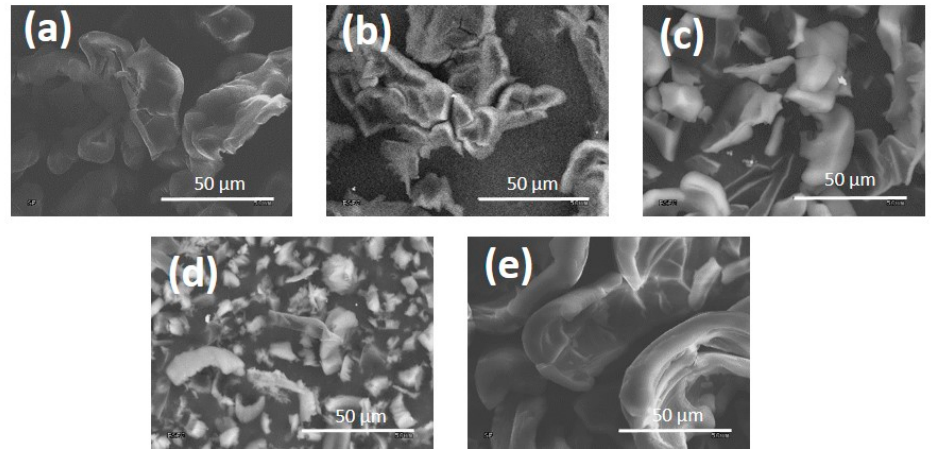
Figure 1. Powder produced using ( a ) methane; ( b ) methane and hydrogen mixture; ( c ) methane and argon mixture; ( d ) methane and oxygen mixture; and ( e ) methane and nitrogen mixture.